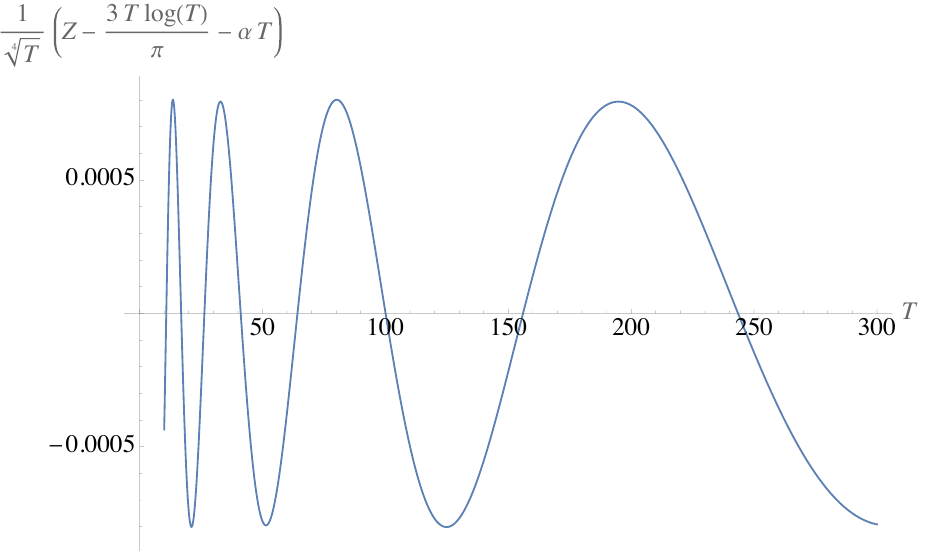
Figure 4 . Scalar part of the SU(3) 1 WZW model with first two leading terms subtracted, rescaled by T 1 / 4 , plotted up to T = 300 . If the Riemann hypothesis is true, then at large temperature, this function will remain bounded. However, if the Riemann hypothesis is false, at large temperatures the oscillations will grow in size and become unbounded (modulo the subtlety explained in footnote 14). In this plot, α := 2 ˆ E ( e 2 πi/ 3 ) + 3 ( γ + log(4 π ) + 24 ζ 0 ( − 1) − 2) ≈ 0 . 975 (see (5.5)). By fitting this 1 E π plot with oscillating functions in log( T ) , we can numerically recover the first few nontrivial zeros of the zeta function. (A similar plot can be made for any c > 1